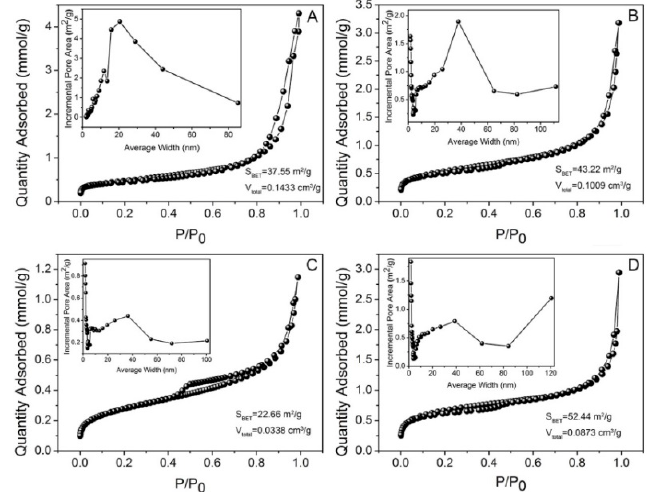
Figure 7. Nitrogen adsorption/desorption isotherms of ( A ) CNA1; ( B ) CNA2; ( C ) CNA3; and ( D ) CNA4. Insets show the Barrett–Joynet–Halenda (BJH) pore size distributions of CNAs.